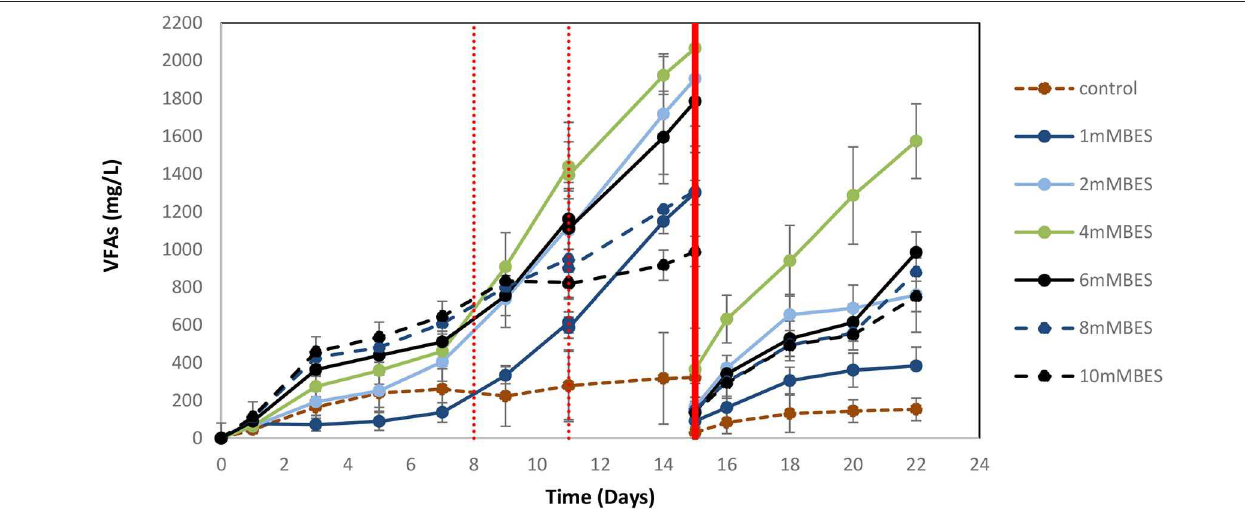
FIGURE 7 | VFAs production over time for anaerobic granular sludge exposed to 1–10mM BES, 100 g/L ZVI and operation at pH 6–6.5. On day 15, 90% of the media was